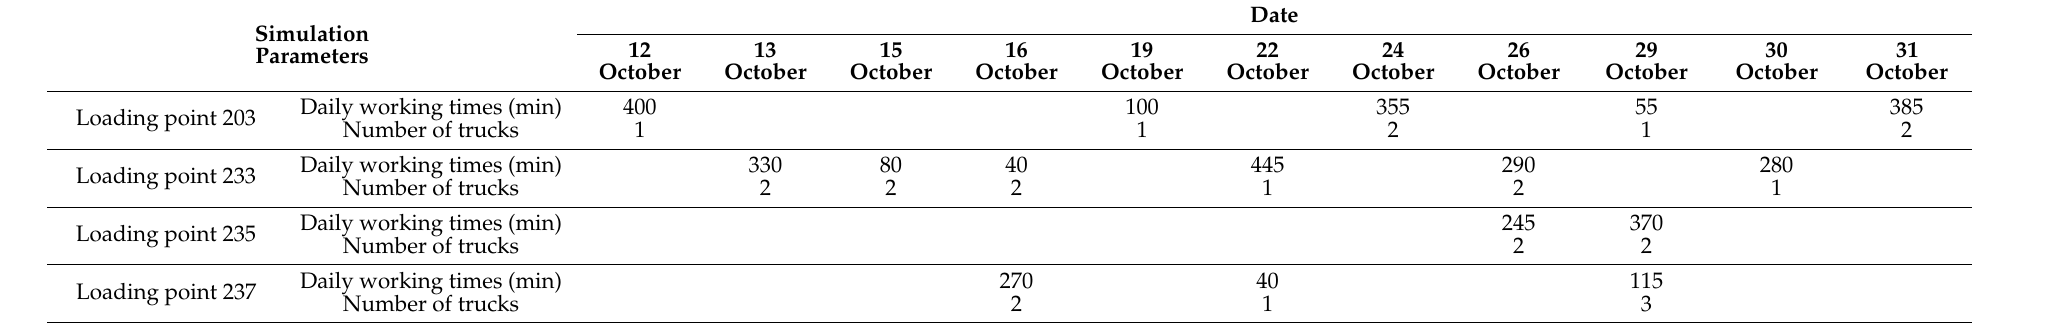
Table 5. Description of the input data of the truck haulage system simulation for ten days in October